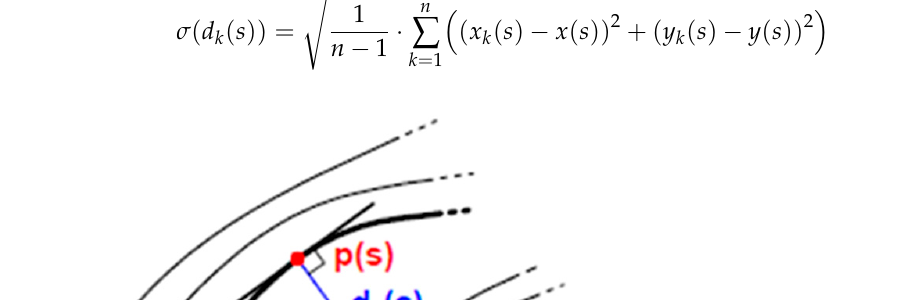
4 of 15 Figure 1. Representation of a general spatial trajectory t and related constraints W(s) . Authors’ elaboration according to [25]. The above Index of Difficulty ( ID t ) is a purely geometric measure derived from infor- mation theory and is uniquely dependent on the prescribed spatial trajectory and relative constraints. It can be applied to any nominal trajectory that travels within a tunnel of var- iable width, W ( s ), during a generic motor task. A narrow tunnel width leads to increased trajectory difficulty. However, this geometric model does not include specific information on the agent (e.g., human, robot) and its end-effector (e.g., hand, finger, foot) employed in the motor task. Therefore, Equation (4) does not capture important differences in agents’ dynamics and motor control ability that may affect the perceived difficulty (hence af- fordance) of a certain constrained motor task. In this study, the geometrical ID t (Equation (4)) is adopted to formulate a novel in- formation-based stochastic model of generalized reaching task difficulty for a specific agent. A generalized reaching task is defined herein as the movement of a given end- effector of a specific agent, with desired initial and final end-effector positions. When a given agent performs multiple trials of a generalized reaching motor task, the observed trajectories of the end-effector will vary stochastically, due to motor noise [28,29]. In par- ticular, the observed trajectories at given speed and environmental conditions will be en- closed within spatial limits W ( s ) that are governed by a combination of factors: in the case of a human agent, for example, the subject’s internal model of motor control (including its dynamics features, such as mass distribution, geometry, joint and actuation limits), the